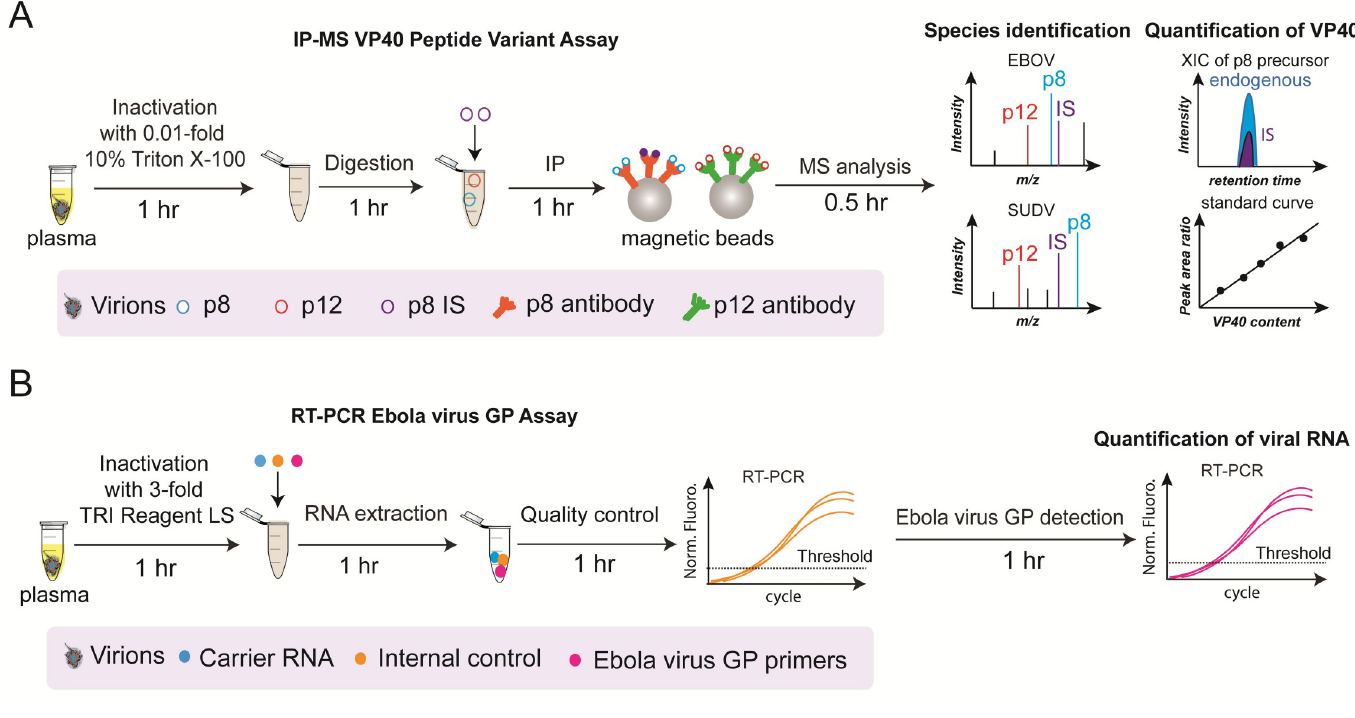
Fig 2. Comparison of the IP-MS assay for VP40 peptide variants with an RT-PCR assay for the GP gene. Both assays employ four steps for sample analysis. ( A ) In the IP-MS assay for VP40 peptide variants, samples are inactivated using a method described by 2005 CDC Interim Guidance and digested to release the target VP40 peptides, which are then immunoprecipitated, and analyzed by mass spectrometry to detect mass differences among the peptide 8 and 12 sequences encoded by different ebolavirus species. The VP40 p8 and p12 target peptides and internal standard (IS) peptide are captured during immunoprecipitation (IP) by target-specific antibody-coupled magnetic beads. The peak area ratio between known amounts of VP40 p8 (blue peak) and its corresponding IS peptide (purple peak) is used to generate a standard curve to permit quantification of endogenous VP40 in clinical samples. ( B ) In the RT-PCR assay for the GP gene, a carrier RNA and a high concentration internal control are spiked into the sample before extraction. Each extracted RNA sample is tested with the internal control RT-PCR RNA Assay to evaluate the yield of the spiked-in internal control. If the internal control amplified within manufacturer-designated ranges, further quantitative analysis of the viral target is performed using standard procedures.